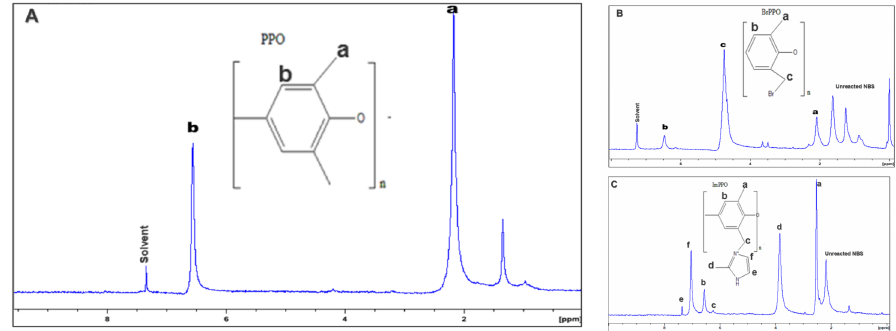
Figure 4. Proton nuclear magnetic resonance (NMR) of PPO ( A ), Br-PPO ( B ), and ImPPO ( C ).